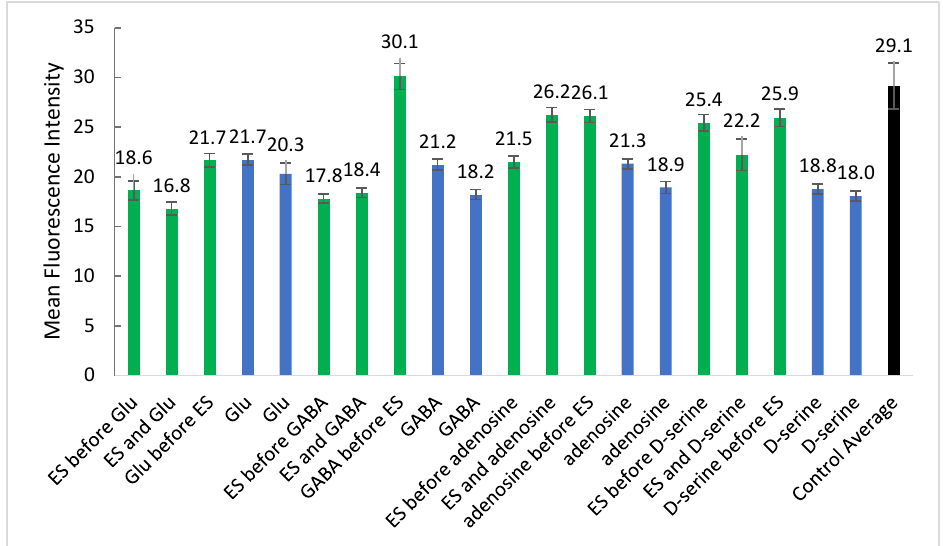
Figure 5. Fluorescence spectrometry measurements of individual solubilized cell solutions incubated with Ca 2+ probe (Fluo4-AM) and with or without ES and neurotransmitters (Figure 1). Green bars indicate cells stimulated before or after additions, blue bars indicate cells with additions but no ES, and black bar indicates PBS control cells with no ES. Values are mean ± SD for 60 measurements of a single well. Control Average is mean ± SD of 240 measurements from 4 replicate wells.